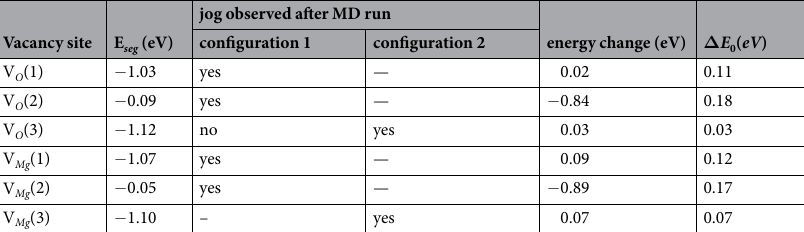
Table 1. The results of MD simulations for a screw dislocation containing a vacancy in MgO. E seg is the segreation energy. “Energy change” denotes the change of the total energies between a localized vacancy configuration and dissociated vacancy configuration. Δ E 0 is the energy difference between a dissociated vacancy configuration and the lowest energy among the localized vacancy